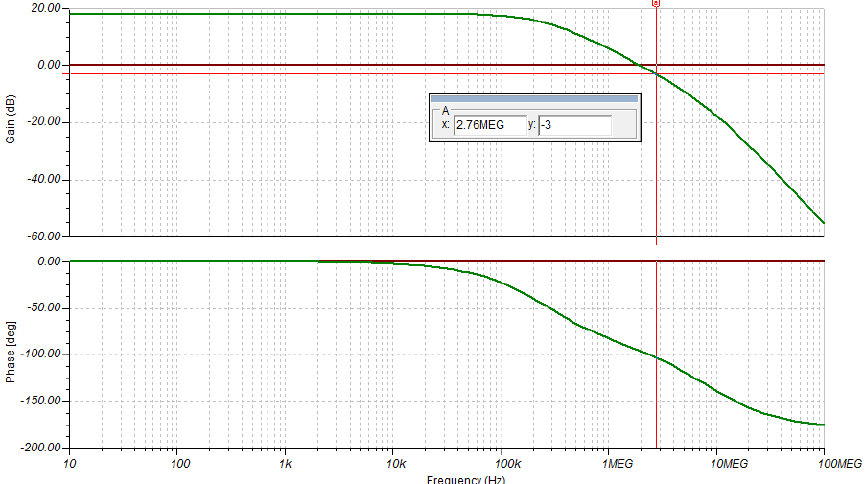
Fig. 10. ac signal characteristic of AGC circuit using LM13700 in TINA-TI SPICE®